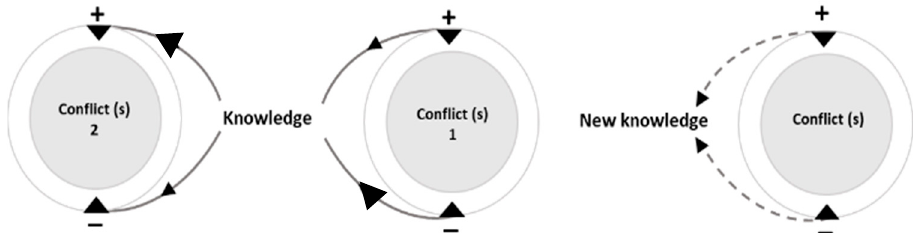
Figure 3. Knowledge that originates from the process of conflict is like a fuel that increases the speed of reform. By challenging the dominant realities, such knowledge in social systems can create the possibility for the emergence of a new order.